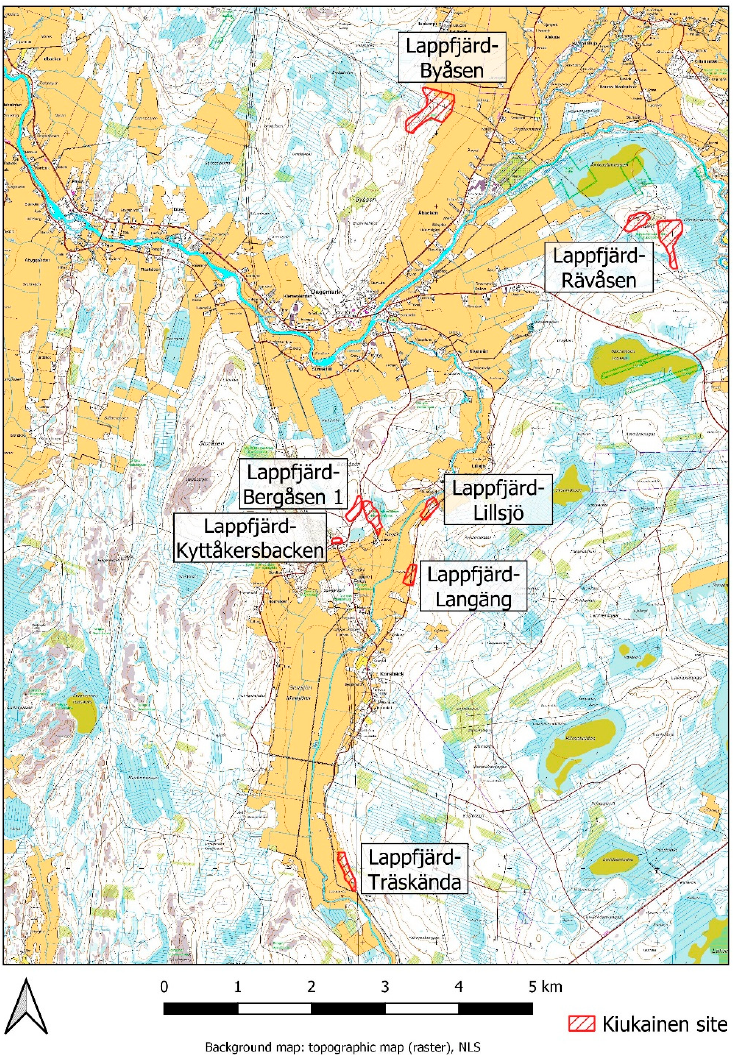
Figure 9. The locations of Kiukainen sites in the Kristiinankaupunki area. Grey areas in the back- ground of the map are rocky areas, while the yellow areas are cultivated fields, and the light green or empty white areas in between are forests.